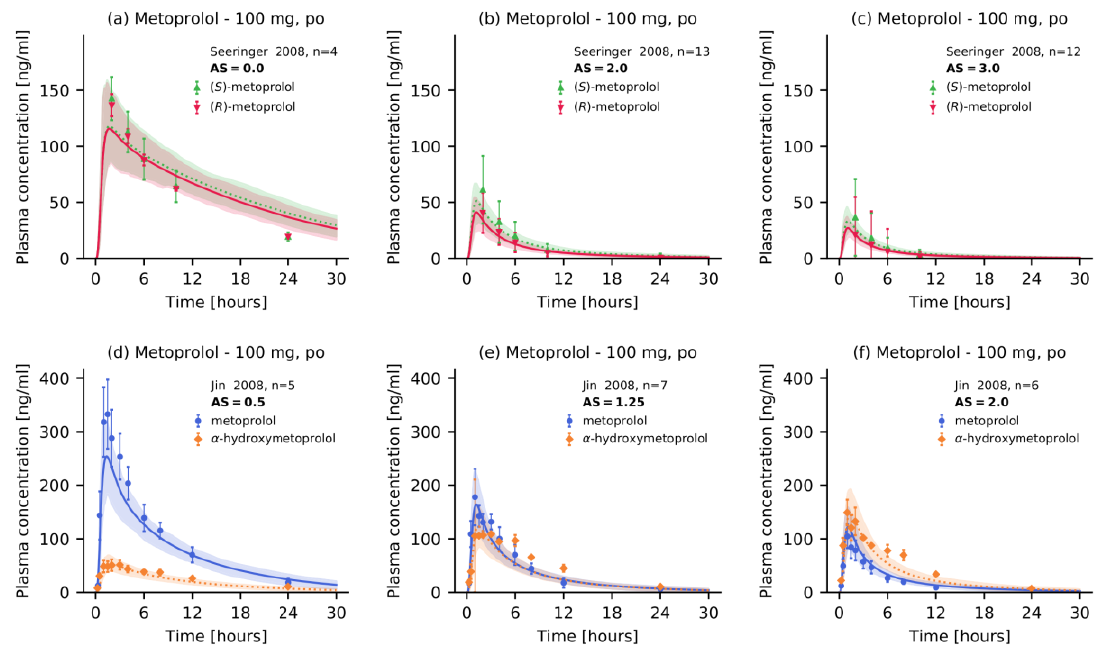
Figure 4. Metoprolol plasma concentrations of the modeled CYP2D6 drug-gene interaction. Model predictions of ( a – c ) (R)-metoprolol and (S)-metoprolol as well as ( d – f ) metoprolol and α hydroxymetoprolol plasma concentration-time profiles of selected metoprolol CYP2D6 DGI studies, compared to observed data [18,51]. Population predictions (n = 100) are shown as lines with ribbons (arithmetic mean ± standard deviation (SD)), symbols represent the corresponding observed data ± SD. Detailed information on all clinical studies is listed in Supplementary Table S2.2.1. AS: activity